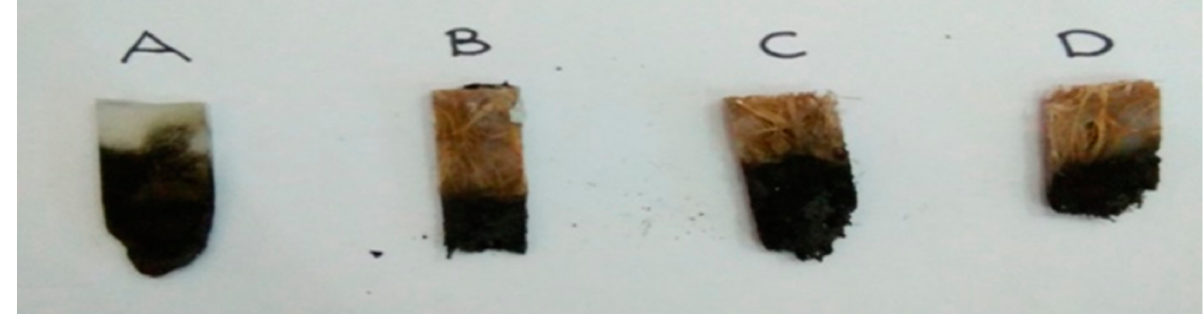
Figure 7. Sample of OPEFB/ PET yarn/magnesium hydroxide reinforced epoxy hybrid composites after the horizontal burning test. ( A ): 0% OPEFB; ( B ): 20% OPEFB; ( C ): 20% OPEFB; 35% OPEFB; and ( D ): 50% OPEFB. Reproduced with copyright permission from Suriani et al. [3], Polymers MDPI.